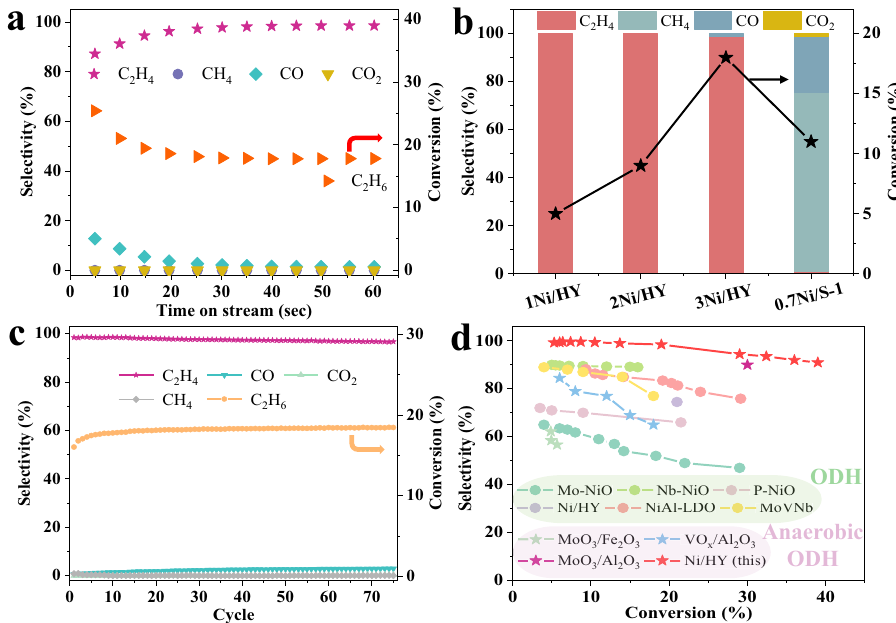
Fig. 2 Performance evaluation of x Ni/HY for ethane ODH. a The conversion and selectivity vs. time for 3Ni/HY sample. b The performance of x Ni/HY and 0.7Ni/S-1. c Long-term stability test of 3Ni/HY during 75 cycles. d Performance comparisons 10, 31, 55 – 58 . It should be noted that Ni species were in the form of metallic Ni in Ni/HY of ref. 47 , which was distinct from the dual active sites of Ni species in the present